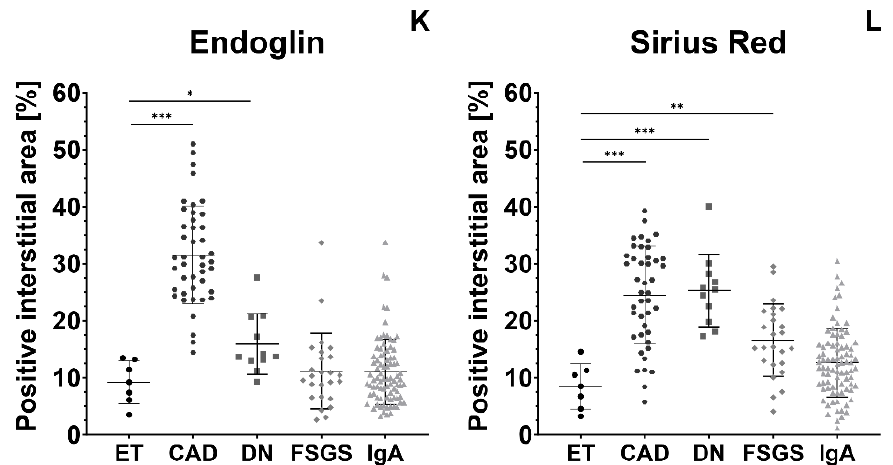
Figure 1. Endoglin expression is increased in various chronic kidney diseases. Representative images of endoglin staining ( A , C , E , G , I ) and Sirius Red staining ( B , D , F , H , J ) in kidney biopsies. Control group consisting of kidney’s excluded for transplantation ( A , B ), patients with chronic allograft dysfunction (CAD) ( C , D ), patients with histologically confirmed diabetic nephropathy (DN) ( E , F ), patients with focal segmental glomerulosclerosis (FSGS) ( G , H ) and patients with IgA nephropathy ( I , J ). Quantitative analysis of the endoglin-positive interstitial area ( K ) and Sirius Red– positive interstitial area ( L ). * p < 0.05, ** p < 0.01 and *** p < 0.001 (Student’s t -tests derived from a one-way ANOVA after arcsine-transformation of the outcome variable). The scale bars represent 100 µm.